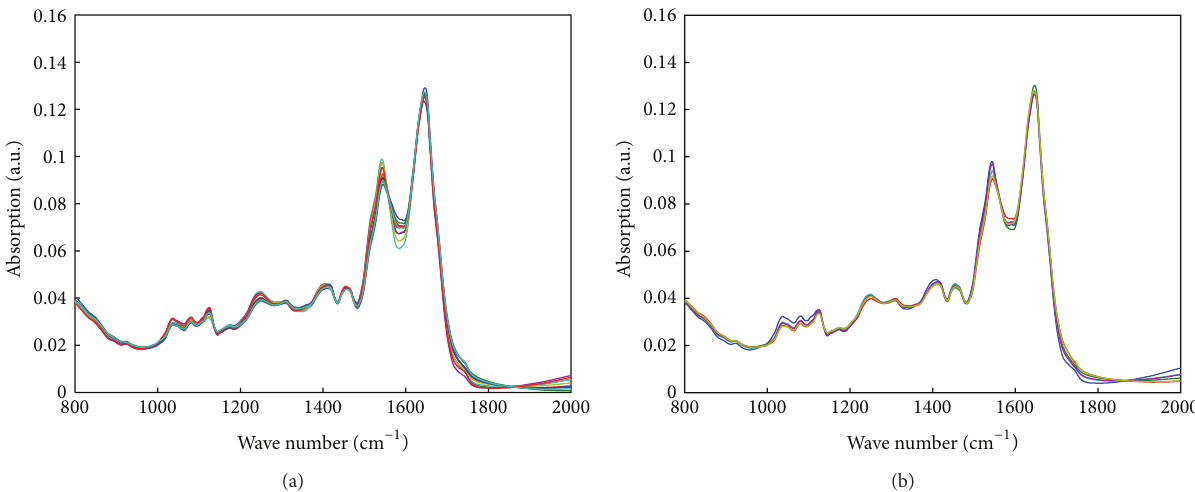
Figure 2: (a) The corrected spectra of the training set by Im-EMSC and (b) the corrected spectra of the test set by